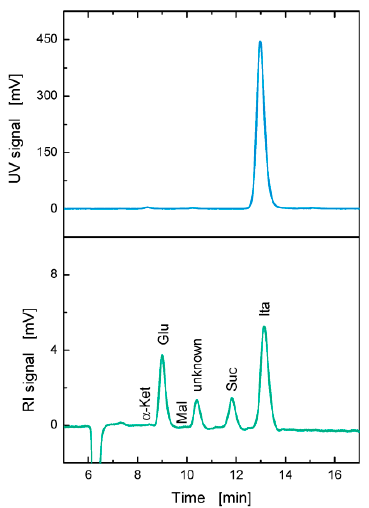
Figure A1. Representative HPLC analysis of a final sample (15 days) of a fed-batch cultivation in 1 L-bioreactor (Section 3.7.). α -ketoglutaric acid ( α -Ket), glucose (Glu), malic acid (Mal), unknown product, succinic acid (Suc), itaconic acid (Ita).